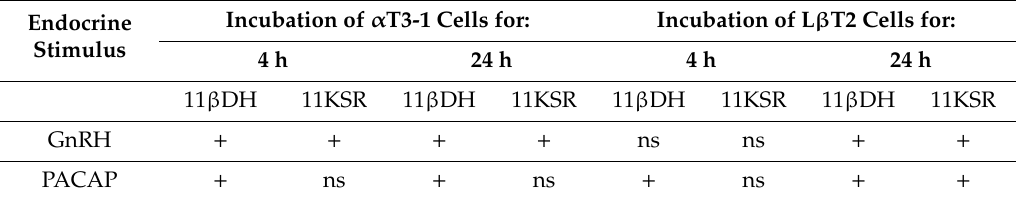
Table 1. Overview of the e ff ects of GnRH and PACAP on the 11 β -dehydrogenase (11 β DH) and 11-ketosteroid reductase (11KSR) activities over 4 and 24 h in α T3-1 and L β T2 cells. ( + denotes significant stimulation of enzyme activity; ns denotes no significant e ff ect on enzyme activity).